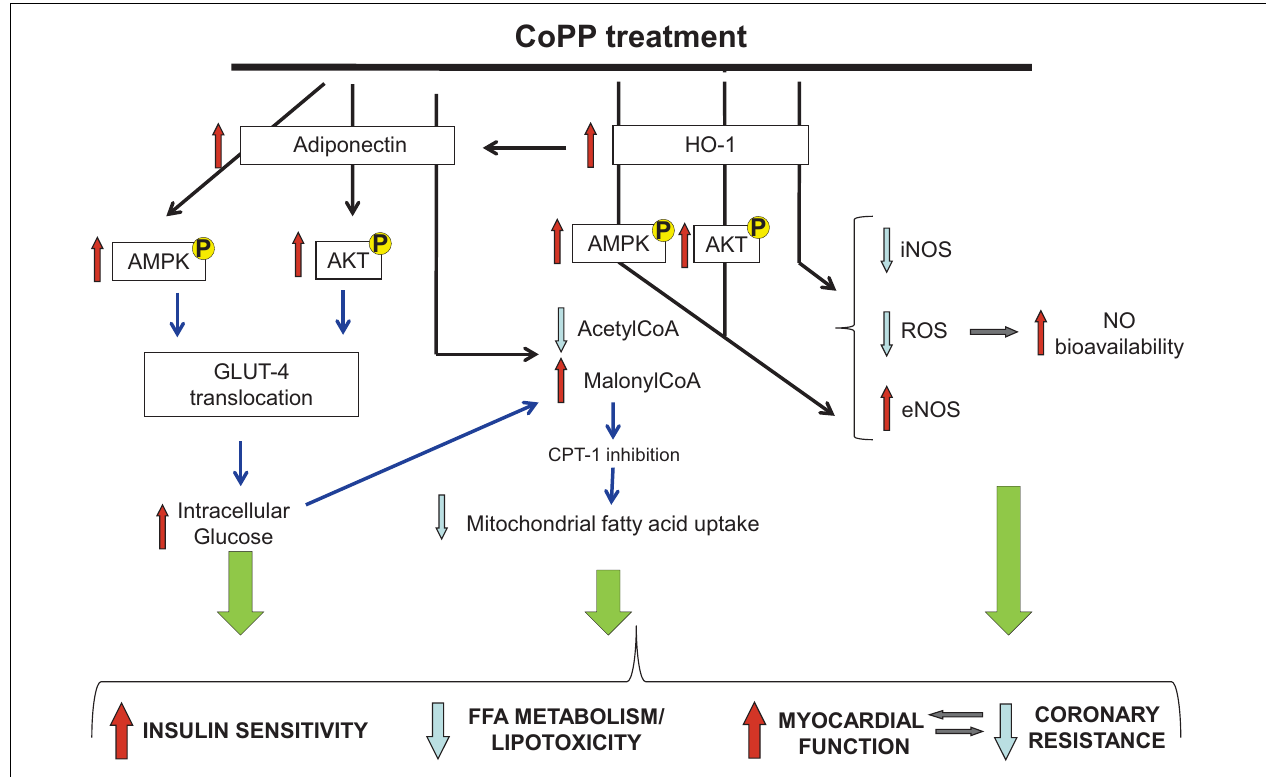
FIGURE 7 | Diagrammatic representation of the major changes observed in diabetic heart after CoPP treatment as compared to untreated hearts. Black arrows represent results demonstrated in this paper and, blue arrows represent previously shown work and/or hypothesis drawn from the literature.